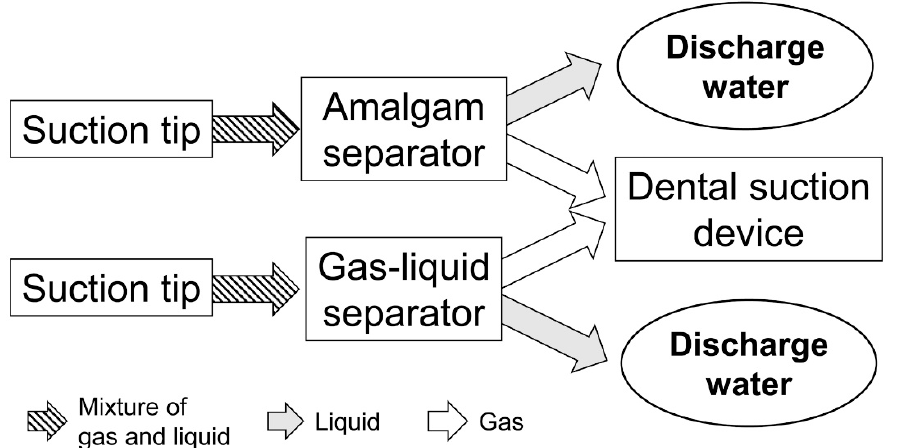
Figure 3. Schematic of the drainage system.